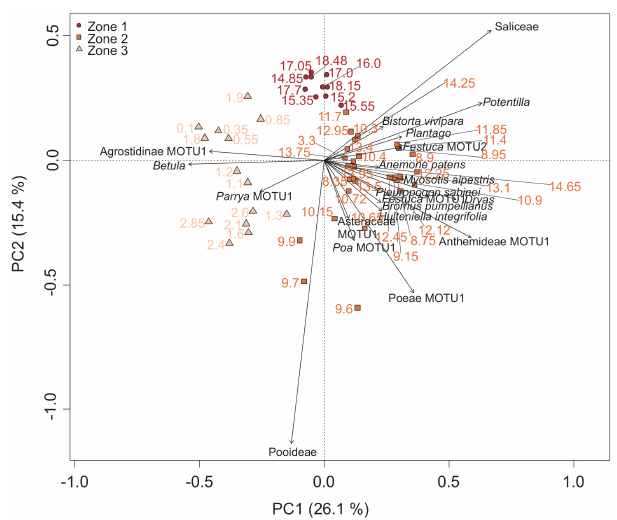
Figure 3. PCA biplot of terrestrial taxa from plant sedaDNA, show- ing a subset of 20 taxa which explained most of the variance in the dataset. Sample depths (m) are coloured according to their corre- sponding zone. Explained variances of the two principal compo- nents (PC) are shown in